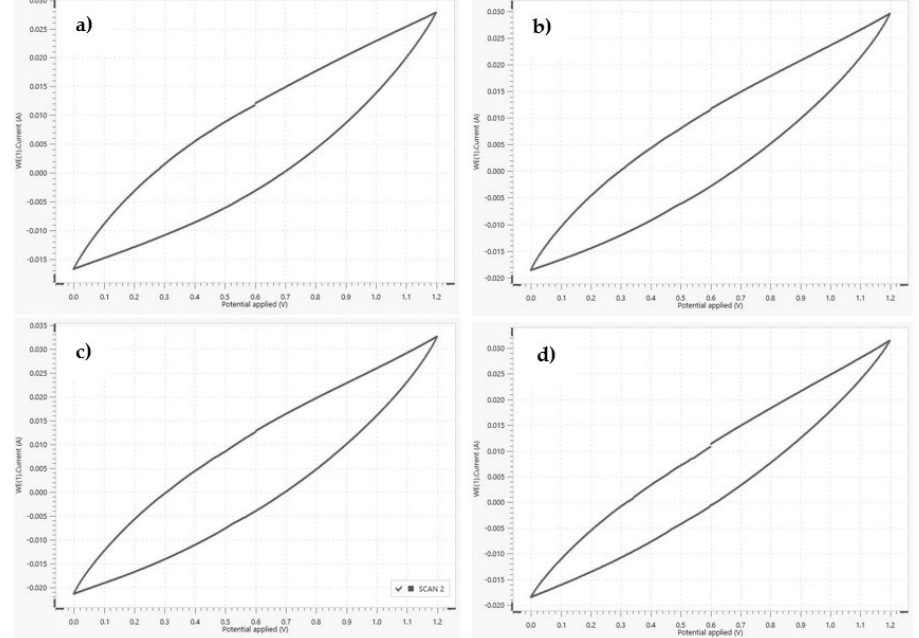
Figure A1. Cyclic voltammograms to 1.2 V, NaCl electrolyte concentration of 0.5 molar and scan rate of 0.05 V/s: ( a ) 300 μ m, ( b ) 400 μ m, ( c ) 500 μ m and ( d ) 600 μ m.